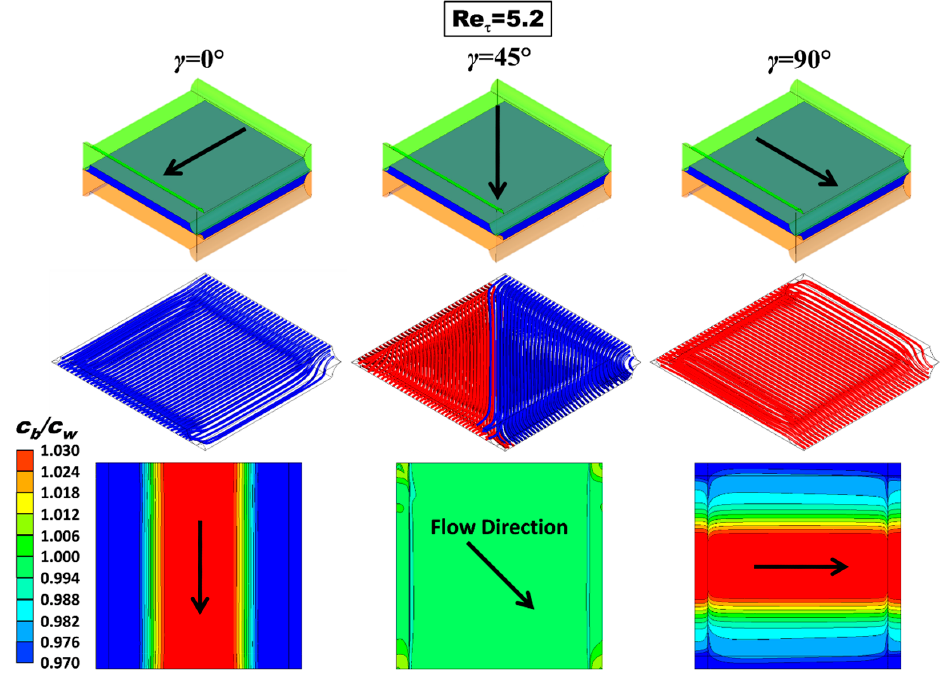
Figure 5. CFD results for the undeformed configuration with P / H = 8 at Re τ = 5.2 (approach velocity ~4 cm / s). Top row: sketches illustrating the flow direction; middle row: 3-D streamlines; bottom row: maps of the concentration polarization coe ffi cient θ = c b / c w on the upper wall. c b = 500 mol / m 3 , flux corresponding to a current density of 50 A / m 2 entering the fluid domain (dilute channel of RED or concentrate channel of ED).